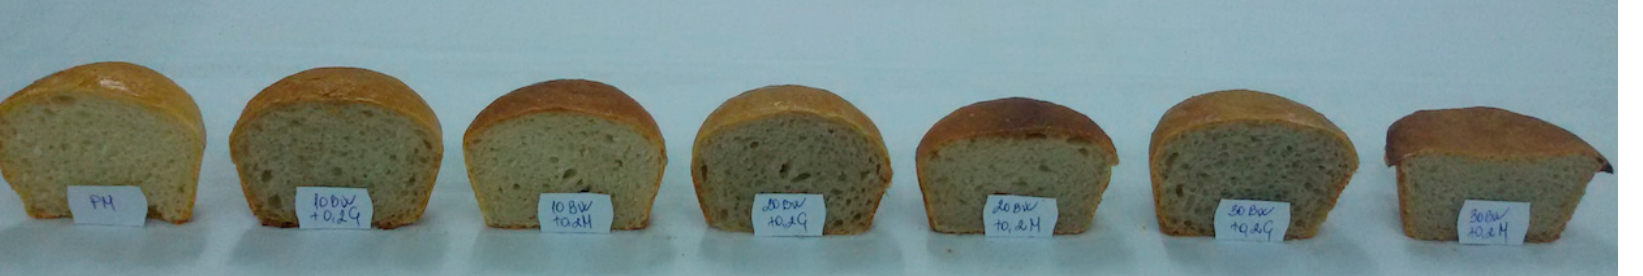
Figure 1. Buns with addition of buckwheat flour and 0.2% guar gum, 0.2% baking improver, respectively and sections of the obtained final baked buns. PM: control sample; 10BW1: buns with 10% buckwheat flour addition and 0.2% guar gum; 20BW1: buns with 20% buckwheat flour addition and 0.2% guar gum; 30BW1: buns with 30% buckwheat flour addition and 0.2% guar gum; 10BW2: buns with 10% buckwheat flour addition and 0.2% Magimix; 20BW2: buns with 20% buckwheat flour addition and 0.2% Magimix; 30BW2—buns with 30% buckwheat flour addition and 0.2% Magimix.